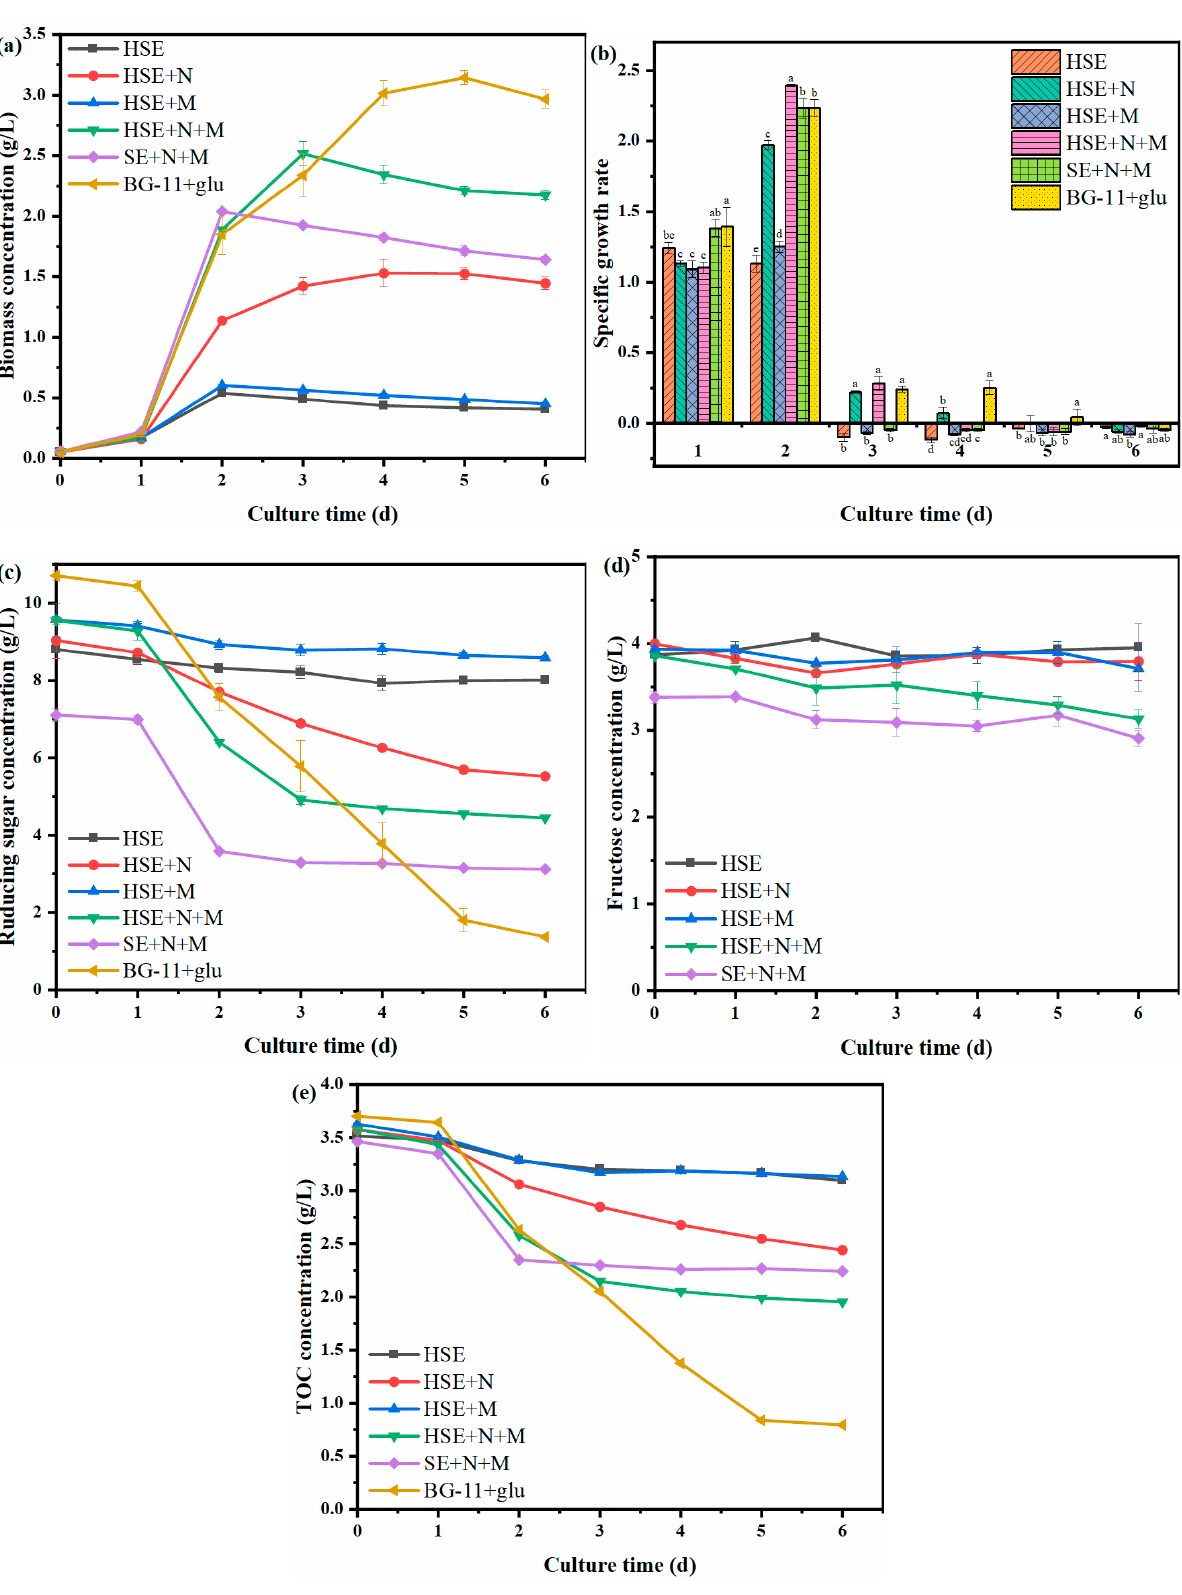
Figure 1. The growth curves of heterotrophic C. vulgaris ( a ), the specific growth rate of heterotrophic